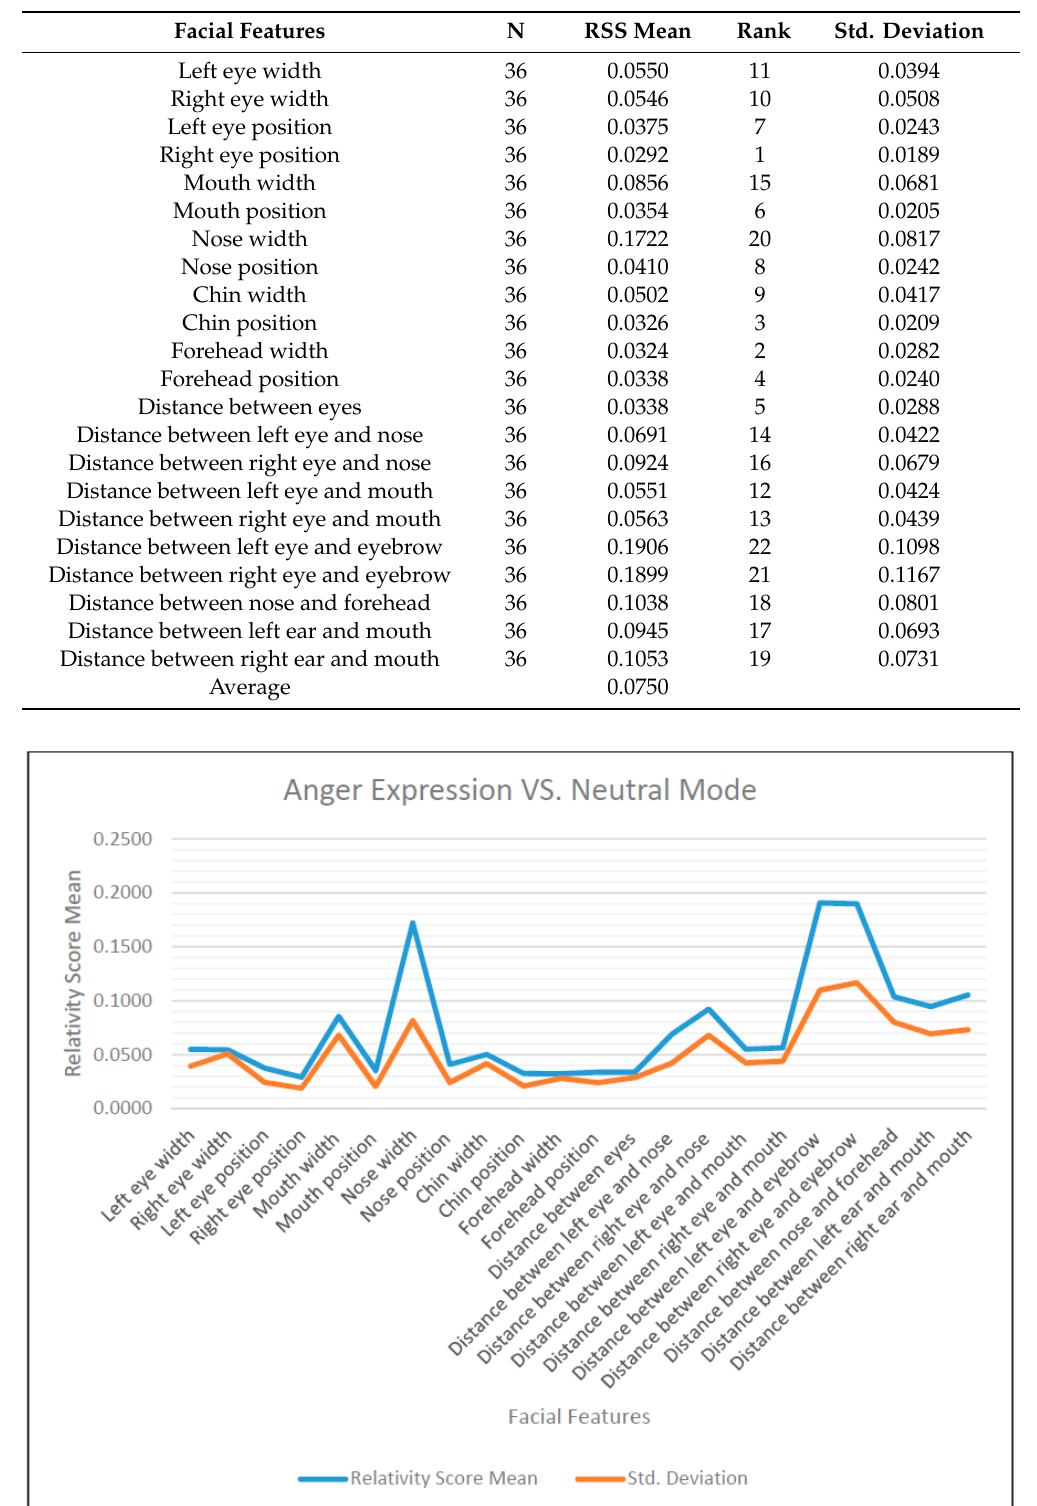
Table 6. The RSS means between anger expression and neutral mode of 22 facial features for 36 subjects.